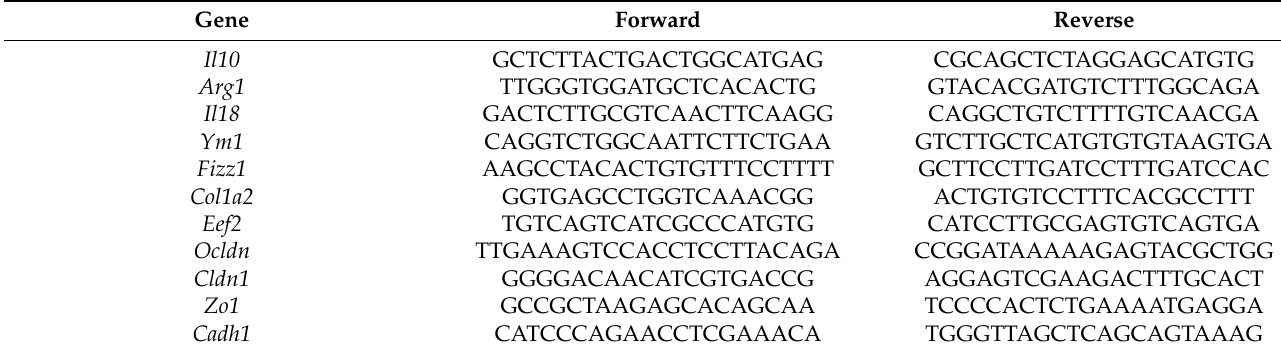
Table 2. Mouse primer